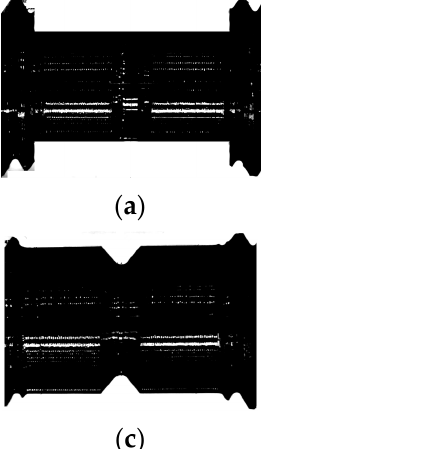
Figure 15. Projected images of the four tensile test bars. ( a ) Non-notch; ( b ) arc-shaped; ( c ) V-shaped; ( d ) square notch.